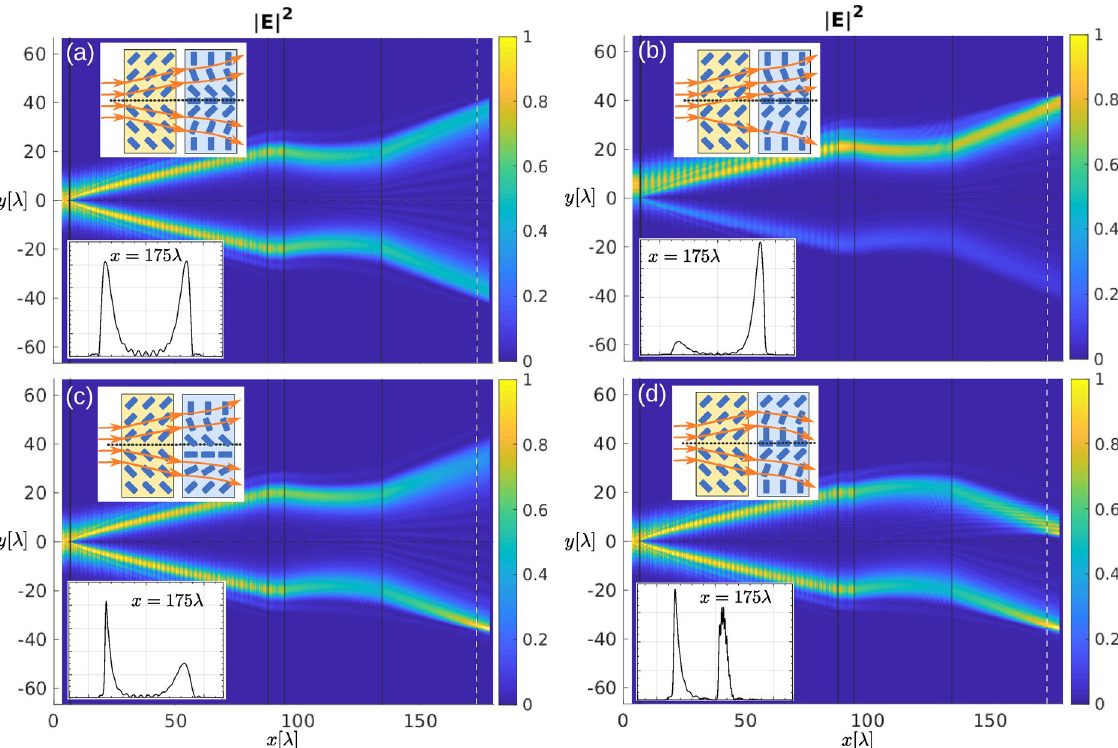
Figure 8. Splitting and controlling the beam. ( a ) Two shifters can be used as a beam splitter: the beam is passed along the border between two areas with different (uniform) nematic director orientation. Separated beams can be deflected at the same or different angle, each with its own deflector or by lens. ( b ) By tuning the position of the splitting area of the director field, intensity in each part of the beam can be determined. ( c ) If the centre of the lens does not coincide with the plane of splitting, the separated beams hit the lens at different distances from its centre and are deflected at different angles. ( d ) Split beams can be deflected in the same direction by using a pair of